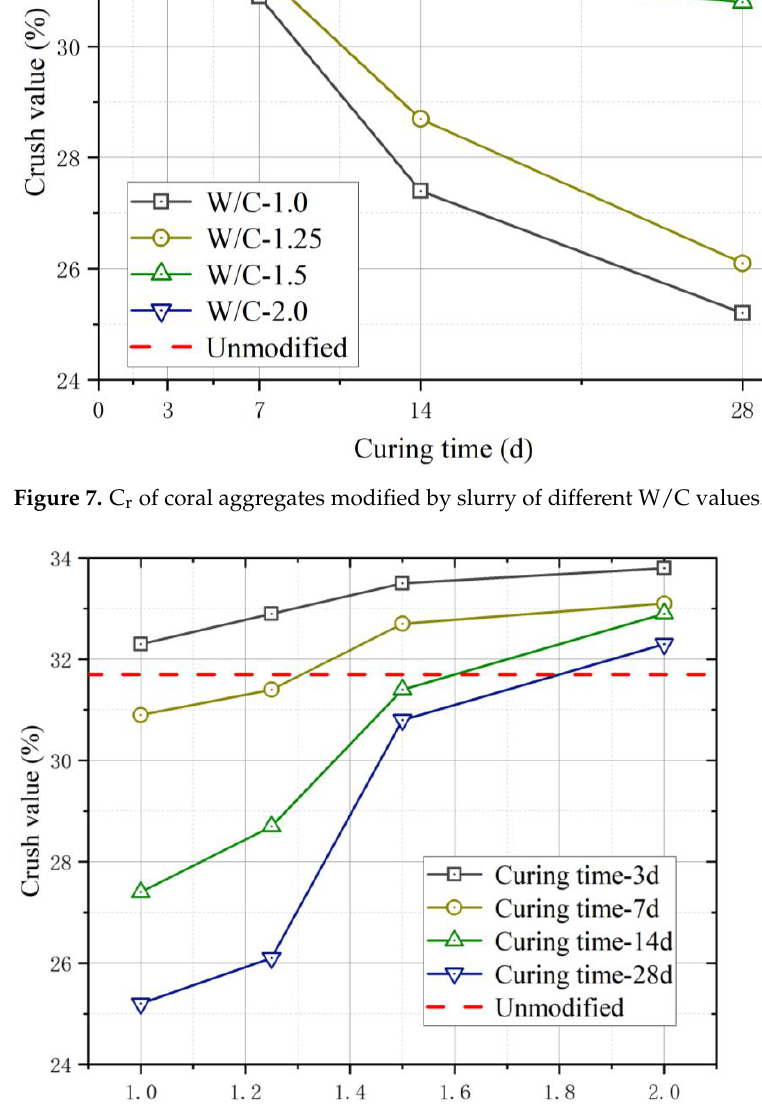
Figure 9. Comparison of C r of different types of aggregates [55 – 57]. 3.3. Workability of Concrete Based on the discussion presented in Sections 3.1 and 3.2, concrete was fabricated using coral aggregates modified by a slurry with a W/C of 1.25 and cured for 28 d. The natural coarse aggregates were replaced by volume at 0%, 25%, 50%, 75%, and 100% re- placement rates to analyse the effects of modification and replacement rate on the worka- bility of seawater and sea sand concrete. The slump and expansion of concrete, which reflect the fluidity of concrete as well as the cohesion and water retention properties of concrete, are important indicators for determining the workability of concrete. Figures 10